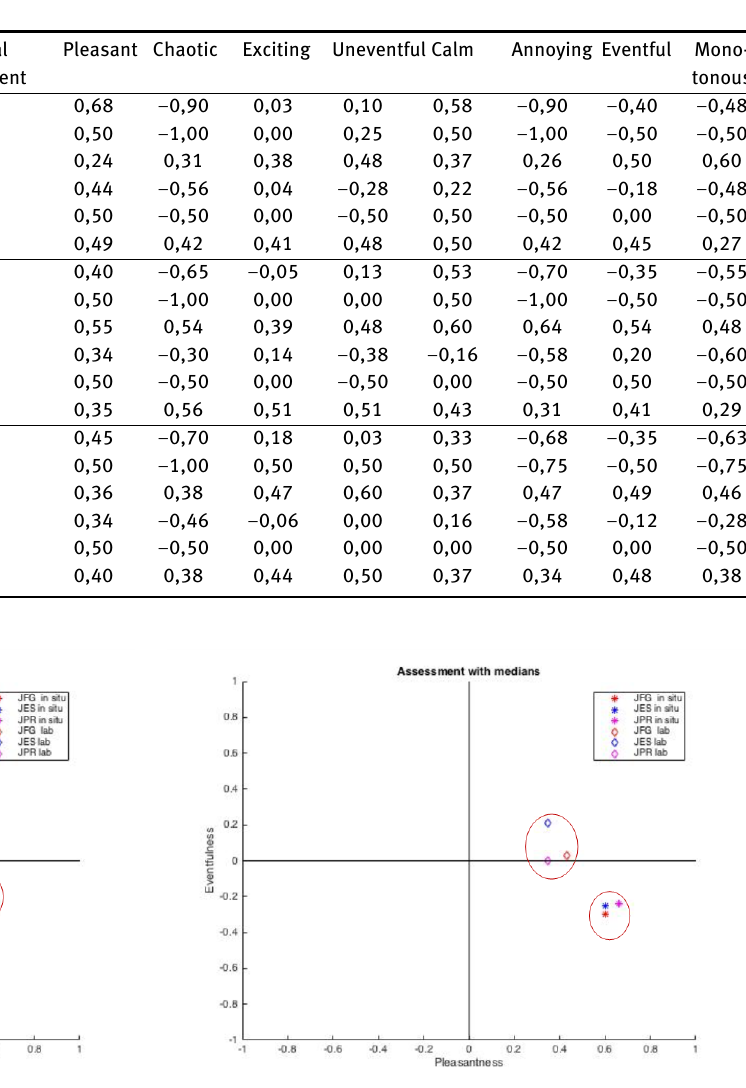
Table 2: Descriptive statistics in situ and laboratory probes.